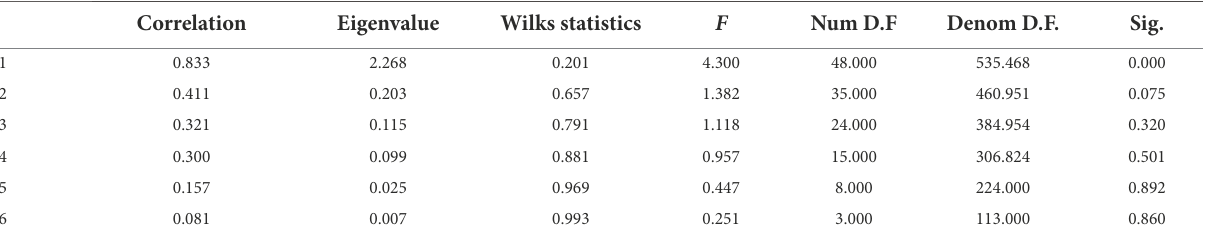
TABLE 9 Canonical correlation statistics.